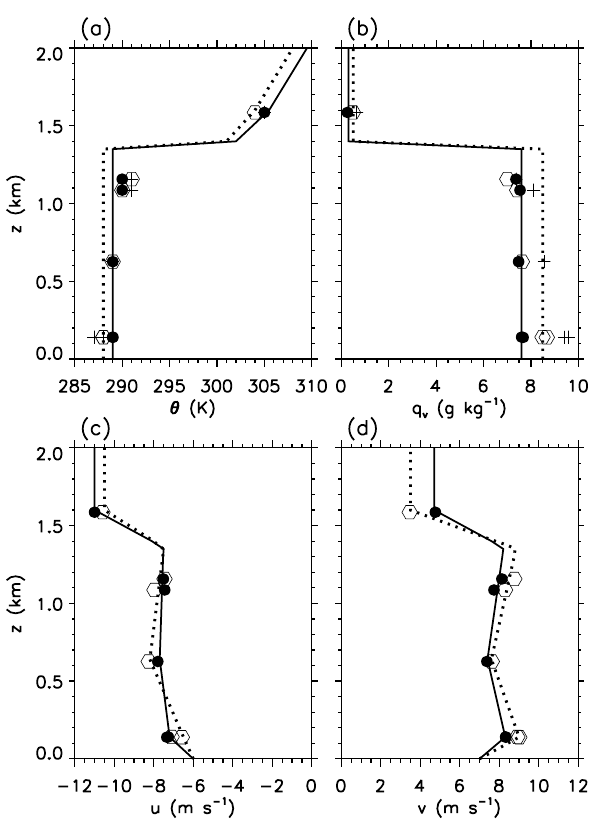
Fig. 1. Vertical profiles of (a) potential temperature θ , (b) water vapor mixing ratio q v , and (c, d) horizontal winds u and v . Black circles, hexagons and plus signs represent RF06 leg-mean measure- ments for overcast regions, POCs and drizzling boundaries. Solid lines and dotted lines are profiles assumed for drier and wetter con- ditions for model